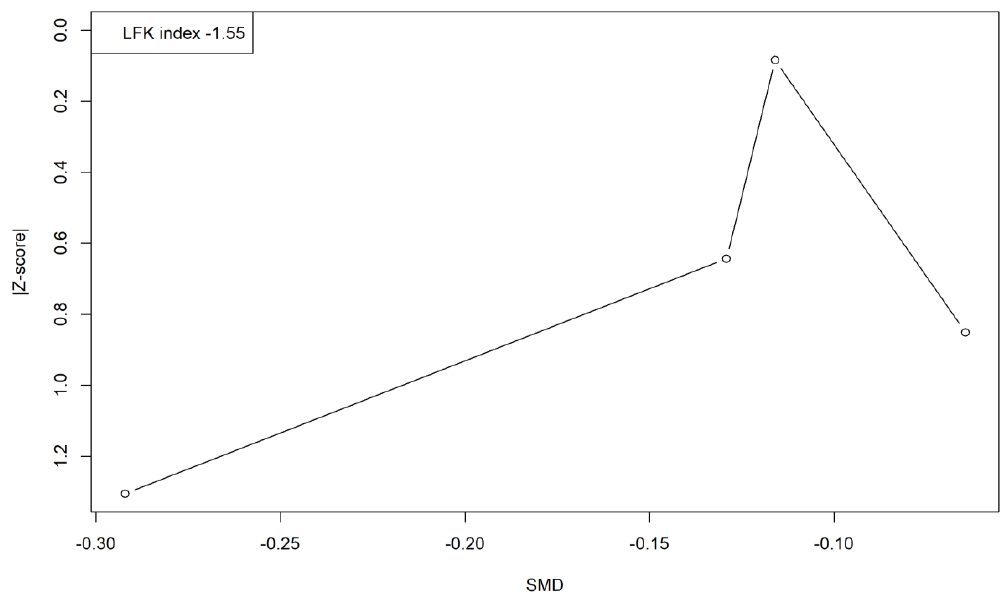
Figure A20. Doi plot and LFK index of all the studies.